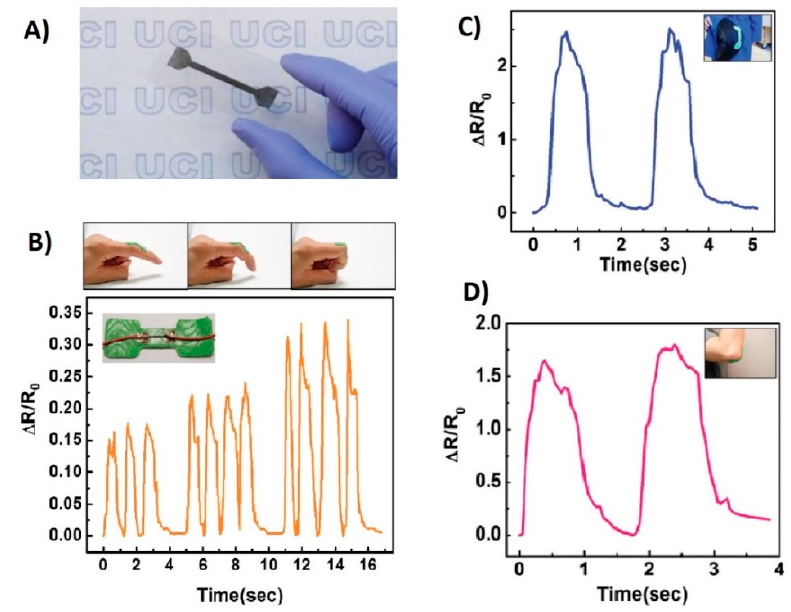
Figure 9. ( A ) Flexible carbon nanotubes (CNT)-based piezoresistive strain sensor, ( B ) change in relative resistance due to bending of the finger, ( C ) due to the movement of knee joint, ( D ) elbow joint [41].